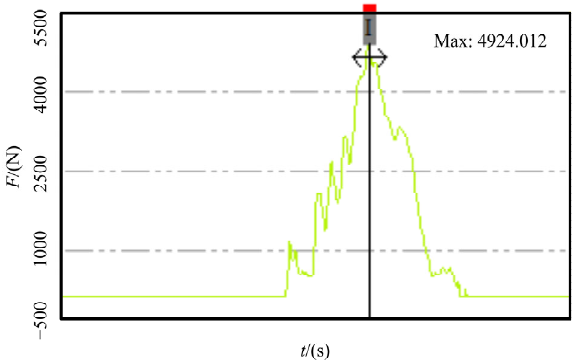
Figure 3. The force on the probe rod during